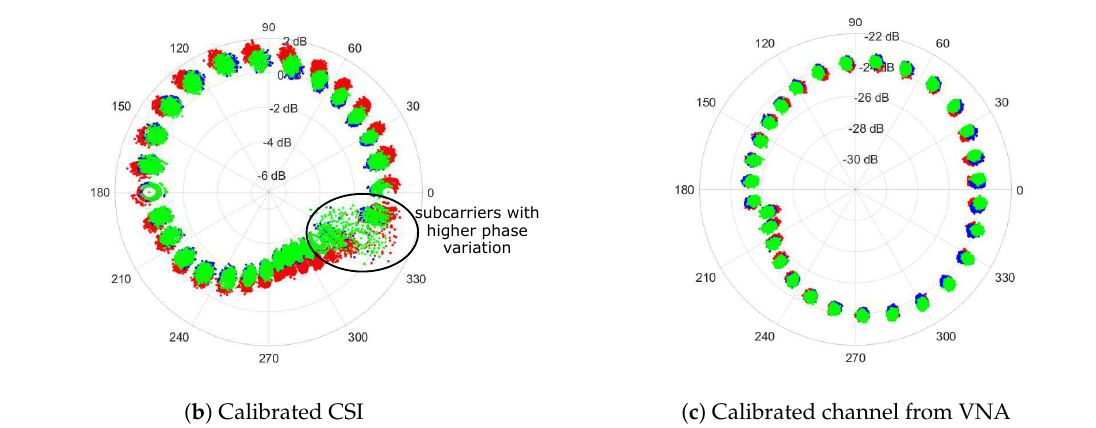
Figure 8. Polar plot of Wi-Fi CSI ( a ) before and ( b ) after calibration in comparison with ( c ) channel measured by VNA within a 10-second period.